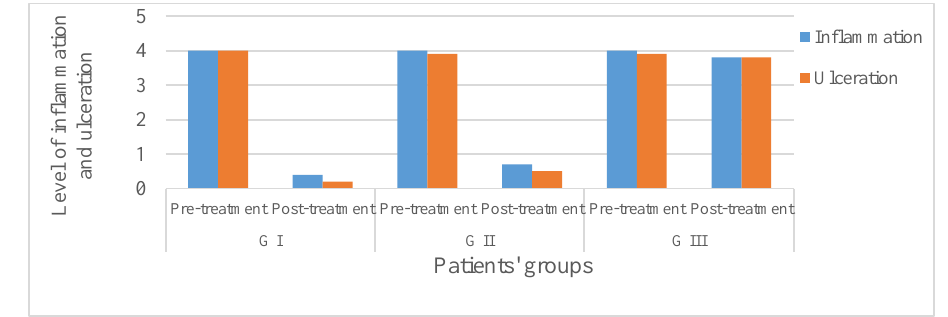
Figure 1: Level of inflammation and ulceration pre- and post-treatment in patients with RAU. 0= None, 1=Minimal, 2=Mild, 3=Moderate, 4=Severe.